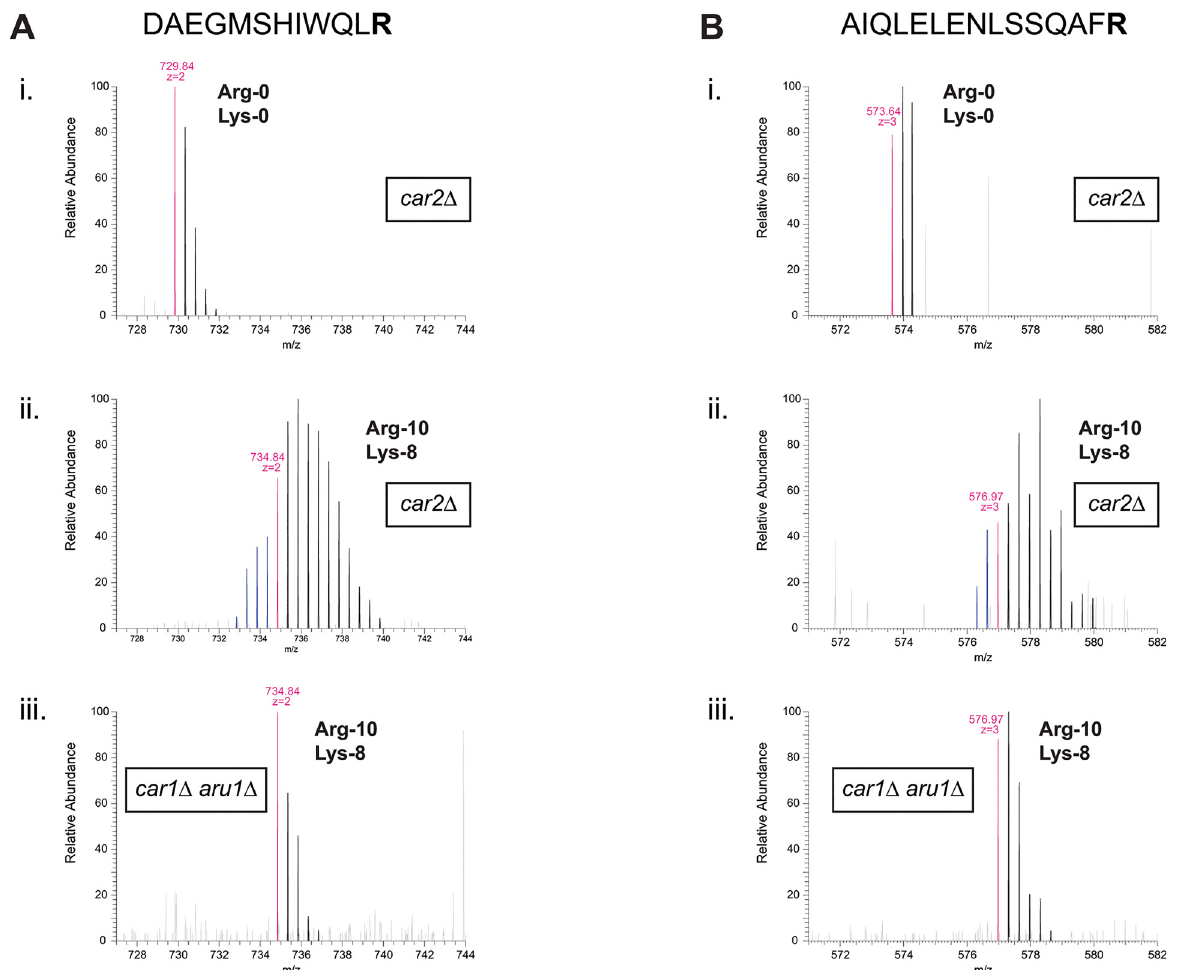
Fig 5. Arg-10 conversion is prevented in arginase-deficient cells. Mass spectra of tryptic peptides (DAEGMSHIWQLR and AIQLELENLSSQAFR in (A) and (B), respectively) from S . pombe Mto1 protein (SPCC417.07c) isolated from (i, ii) car2 Δ arg1-230 lys3-37 or (iii) car1 Δ aru1 Δ arg1-230 lys3-37 cells, grown in either (i) unlabeled arginine (Arg-0) and unlabeled lysine (Lys-0), or (ii, iii) 13 C 615 N 4 -arginine (Arg-10) and 13 C 615 N 2 -lysine (Lys-8), as indicated. In peptides isolated from car2 Δ cells grown in Arg-10, extensive conversion is observed, resulting in both higher-molecular-mass peaks and lower-molecular- mass “ pre-peaks ” (ii; see also Figs 1 and 2). These are not observed in peptides from car1 Δ aru1 Δ cells grown in Arg-10 (iii). Mass-to-charge (m/z) ratios of monoisotopic peaks for each growth condition (i.e., assuming no conversion of labeled arginine) and inferred peptide charge-states are indicated in magenta. Pre-peaks are indicated in